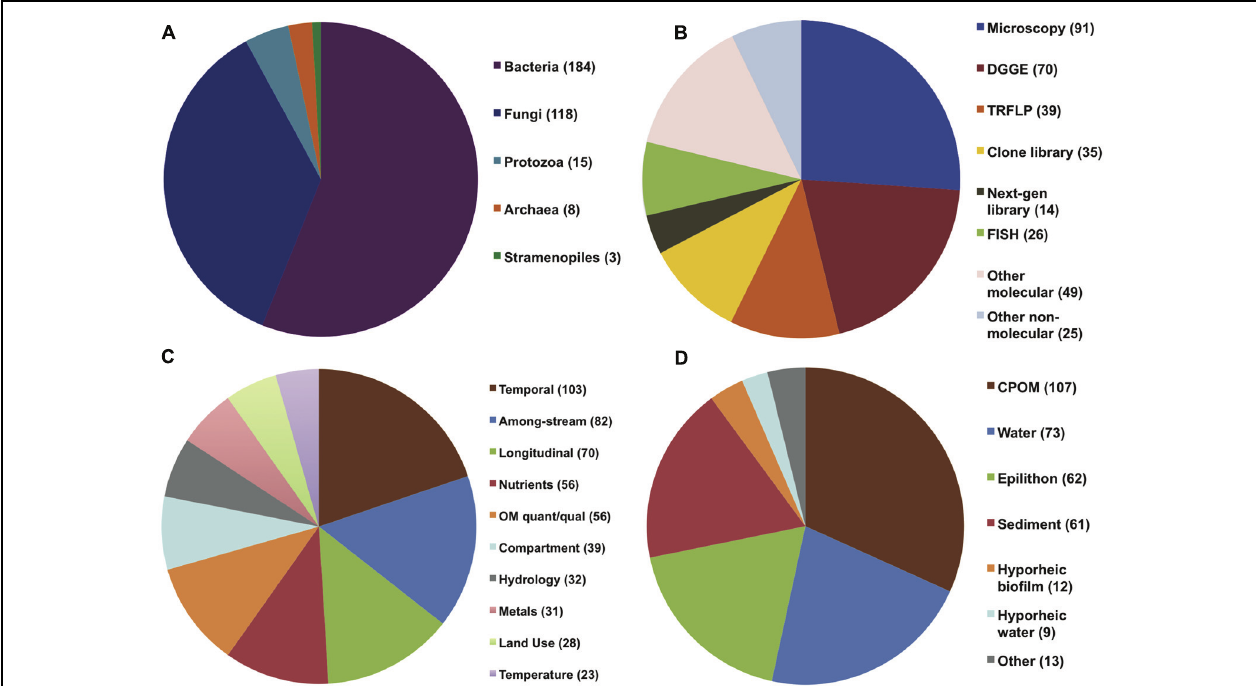
FIGURE 1 | Pie charts showing distribution of (A) organism of study, (B) methodology used in study, (C) environmental drivers, and (D) compartment of study among all papers (294) included in the analysis.